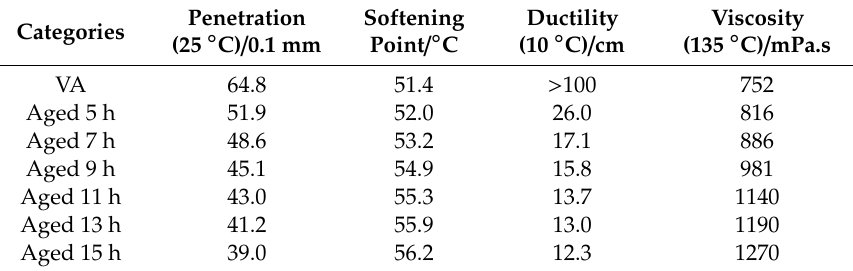
Table 1. The basic properties of virgin asphalt (VA) and six aged asphalts.